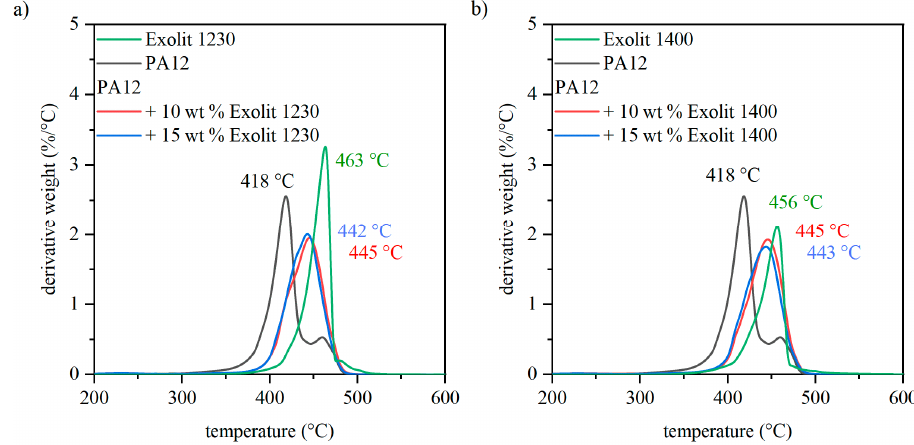
Figure 7. Derivative weight over the temperature of the polymer, flame-retardant filler, and composite powders for different flame retardant concentrations.